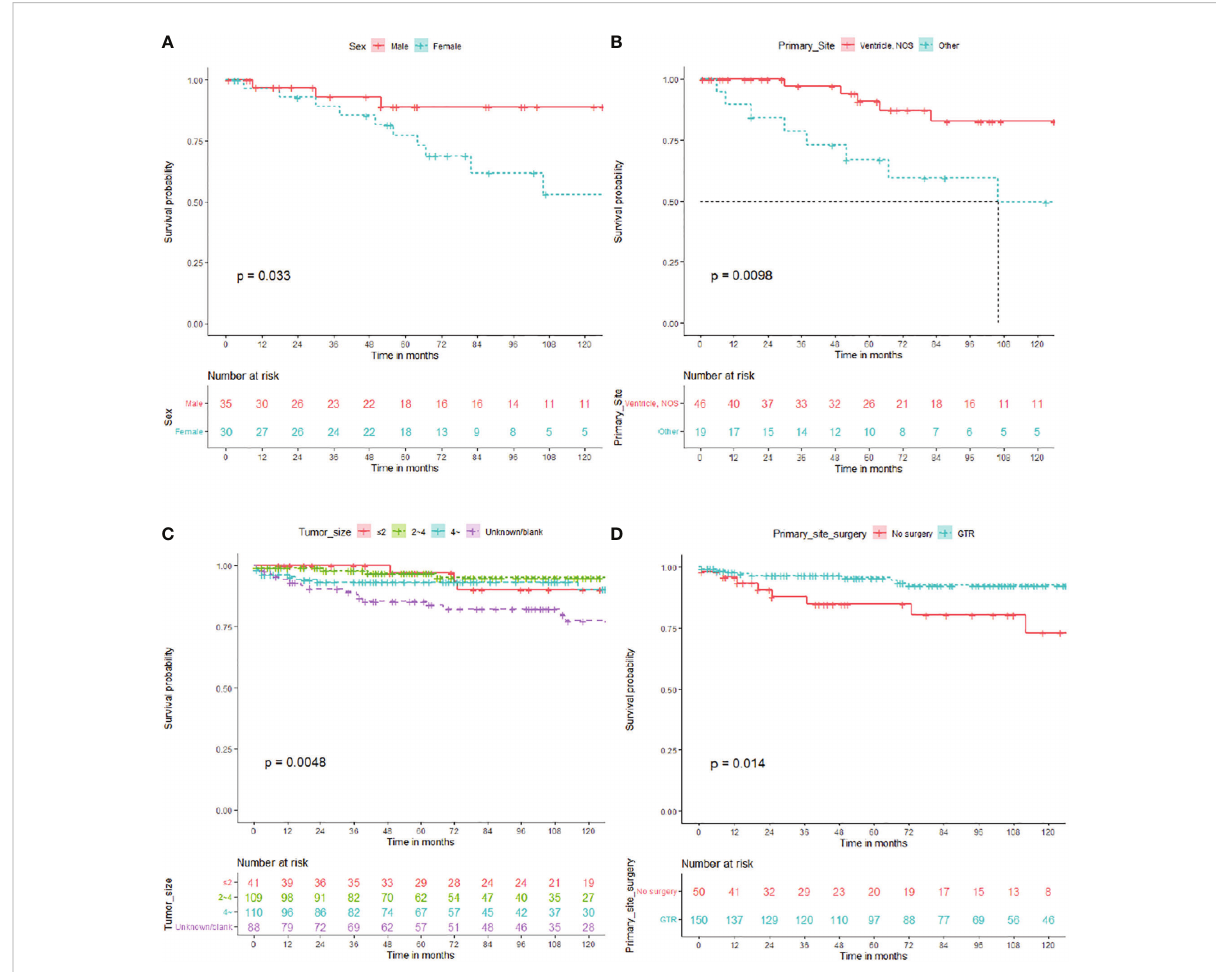
FIGURE 4 Overall survival (OS) for central neurocytoma in the radiotherapy and no radiotherapy. (A) OS among the different sex groups in the radiotherapy subgroup. (B) OS among the different primary site groups in the radiotherapy subgroup. (C) OS among the different tumor size groups in the no radiotherapy subgroup. (D) OS. among the different primary site surgery groups in the no radiotherapy subgroup. OS, overall